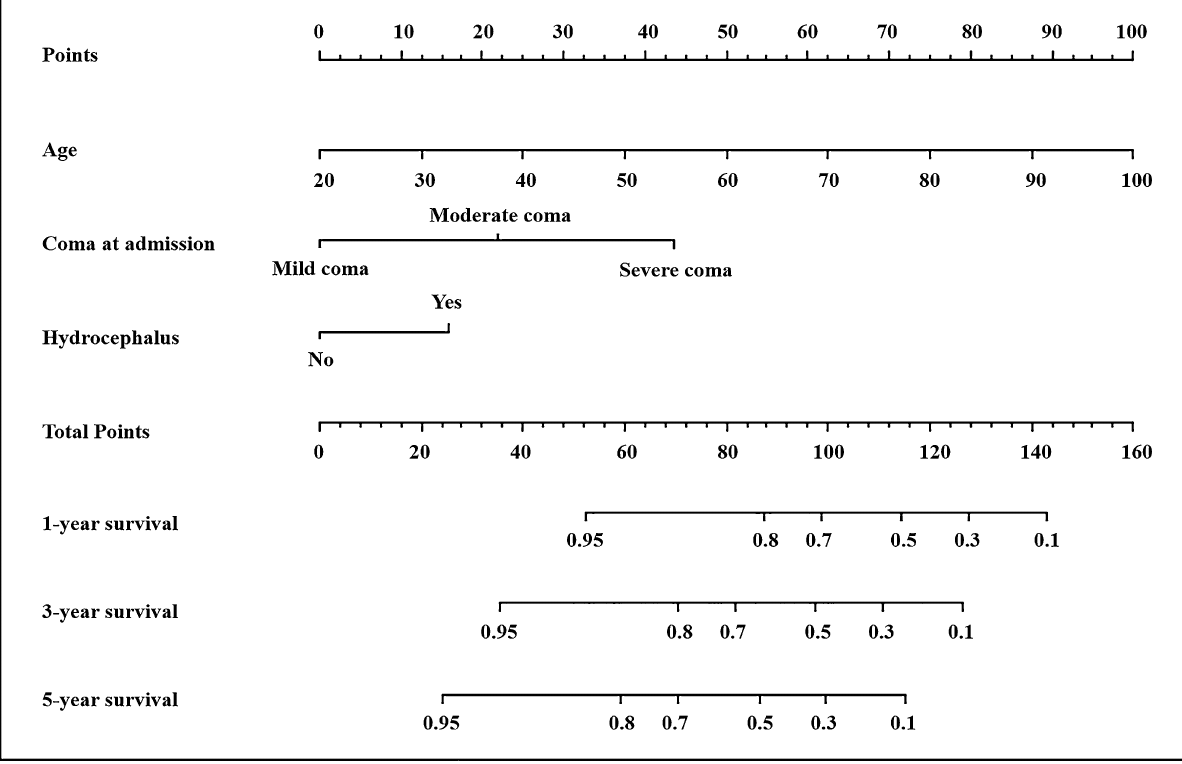
Figure 4. Nomogram for predicting long-term survival in patients with sICH. Survival analysis was performed with Survival R package version 3.3–1 (Threneau 2022). Regression modeling strategies were performed with Rms version 6.3–0 (Harrell